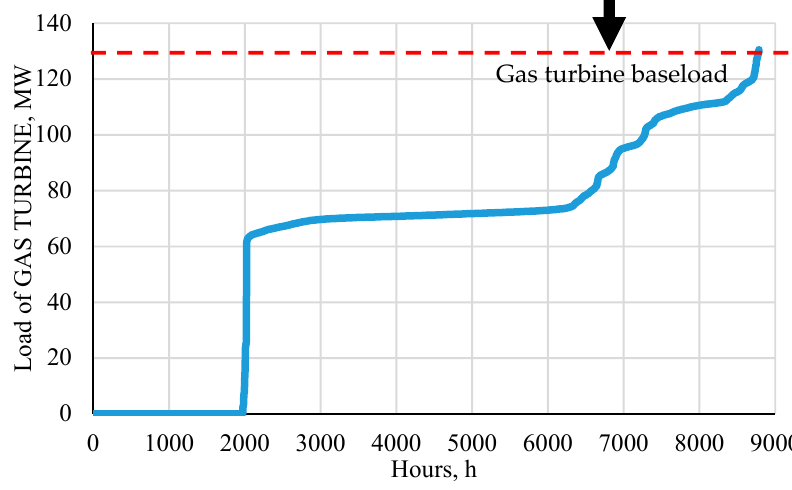
Figure 1. Actual operating hours of GE9171E gas turbine in Tianjin, China.